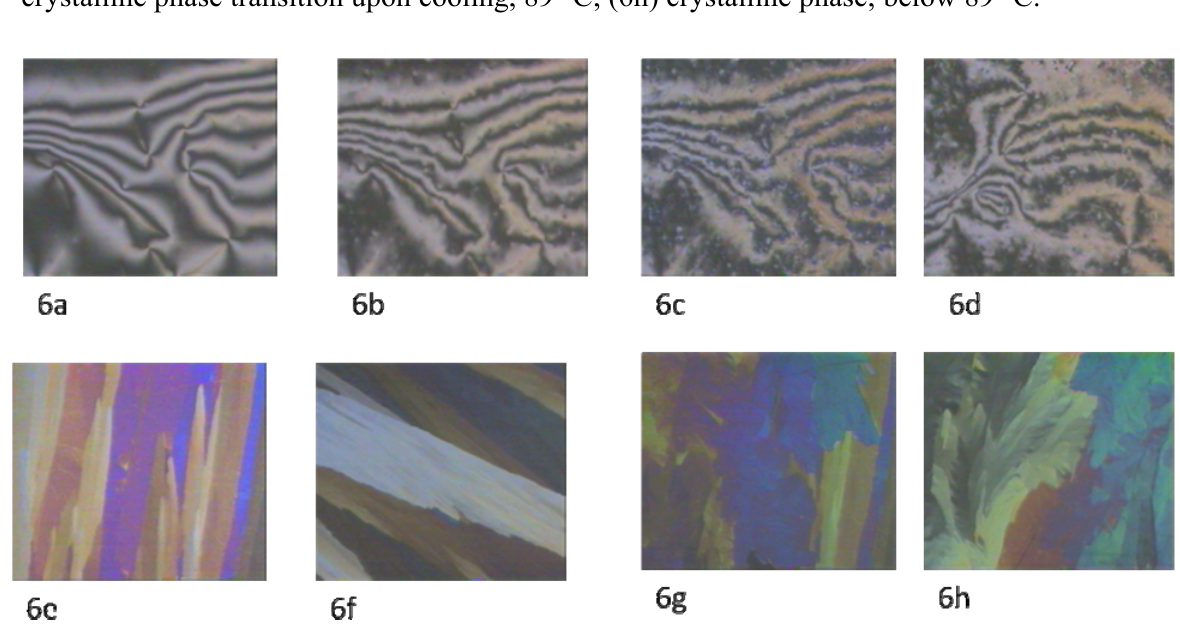
Figure 6. Transition from nematic to smectic to crystalline. (6a) Point singularities as evidence of nematic Schlieren texture, 150 ° C; (6b) transition from nematic to smectic X2 upon cooling, 117 ° C; (6c), (6d) smectic X2 phase, 117 ° C; (6e), (5f) fast transition from smectic X2 to smectic X1. Mosaic texture of smectic X1, 103 ° C; (6g) smectic X1 to crystalline phase transition upon cooling, 89 ° C; (6h) crystalline phase; below 89 °